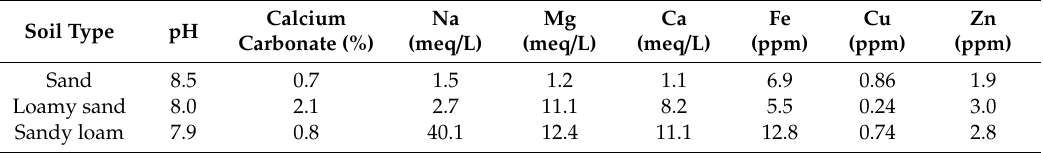
Table 3. Observed chemical characteristics for soil types used in the